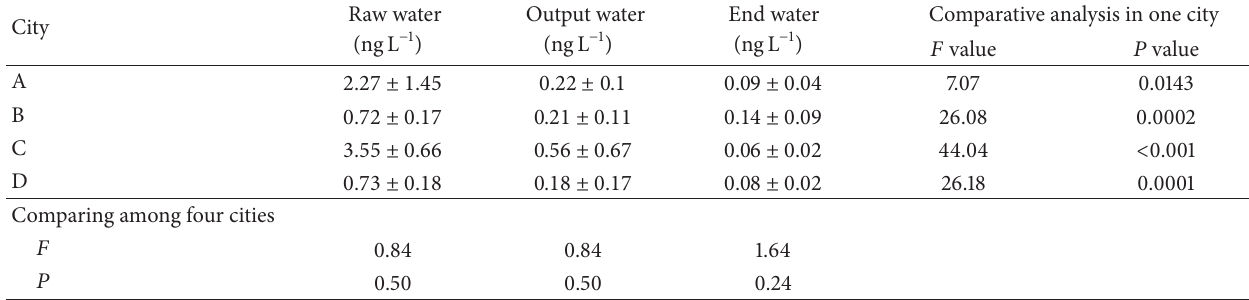
Table 1: The statistical analysis of GSM levels in four cities ( 𝑛 = 60 ).